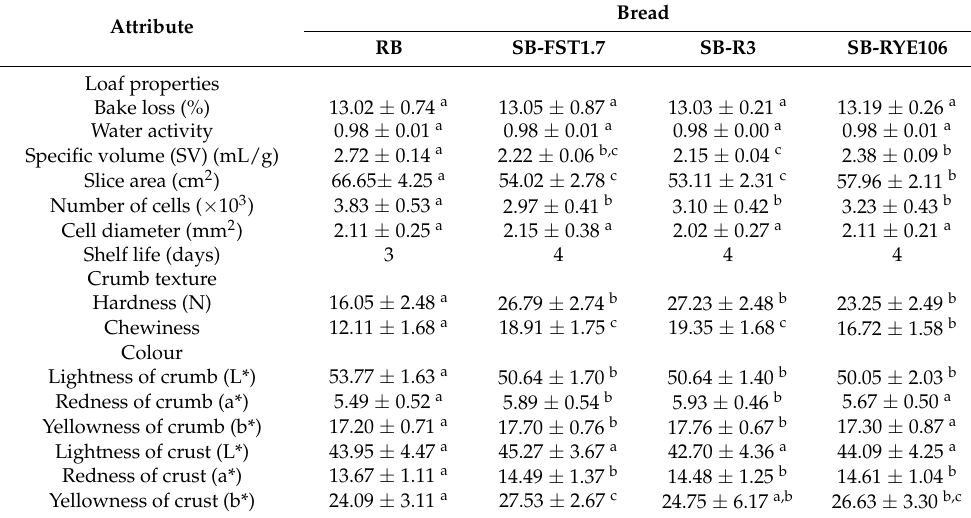
Table 5. Quality assessment of whole-wheat breads: RB, produced with commercial baker’s yeast preparation (2%; Puratos, Belgium) and with baker’s yeast and sourdough (20%) based on homofer- mentative fermentation by Lactiplantibacillus plantarum FST1.7 (SB—FST1.7), Lacticaseibacillus paracasei R3 (SB—R3), and Pediococcus pentosaceus RYE106